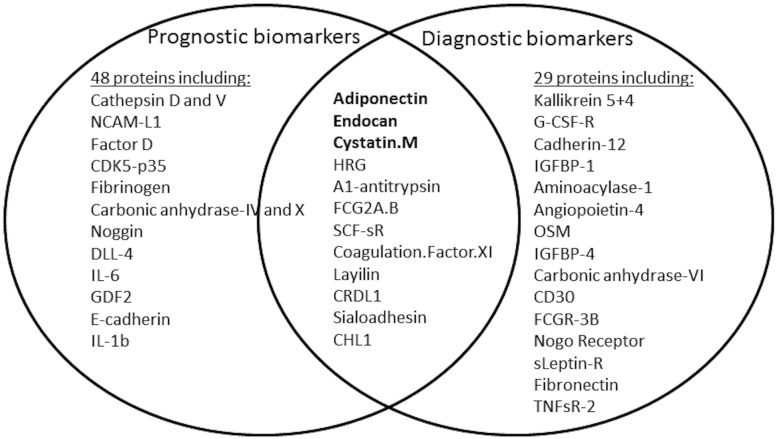
Venn diagram of prognostic and diagnostic protein predictors based on the univariate analysis with p<0.05.Twelve proteins were identified as differentially expressed at both time-points; 48 proteins were only predictive at baseline; and 29 only at follow-up. Proteins in bold were among top 20 in both prognostic and diagnostic lists.